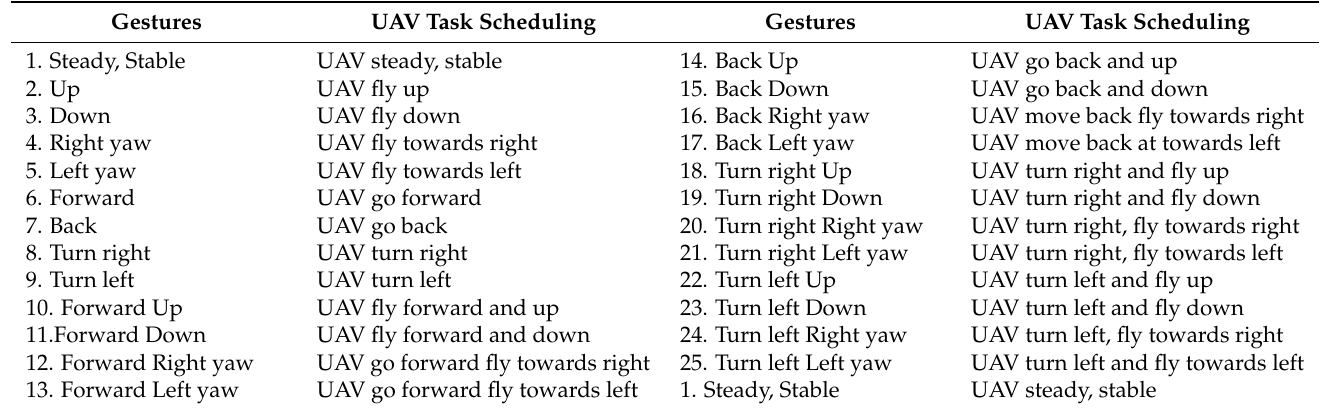
Table 3. Hand gestures and UAV task